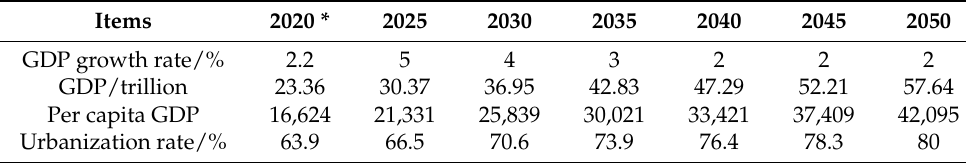
Table 2. Economic and social development indicators of China from 2020 to 2050.